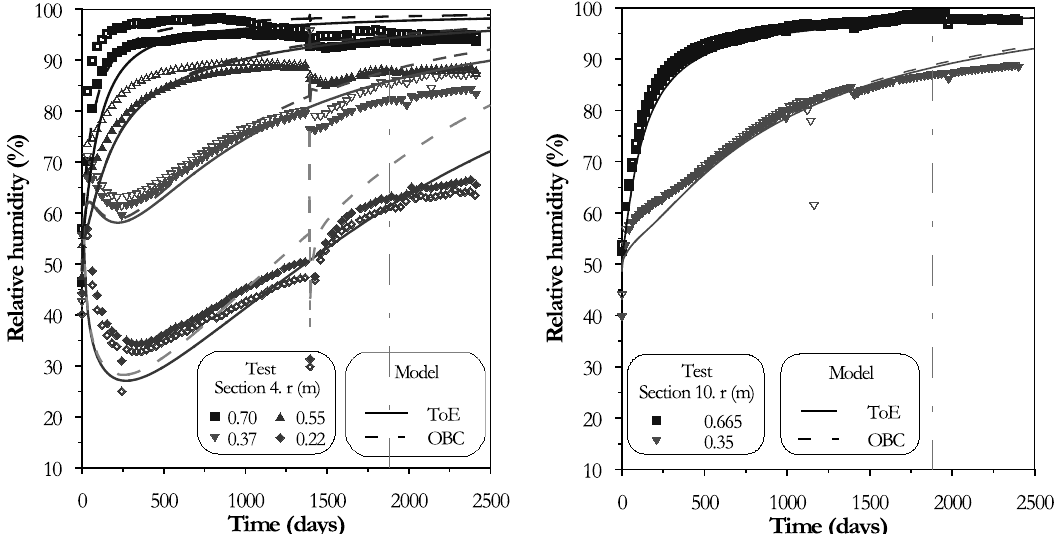
Fig. 12 – Evolution of the relative humidity. Observed versus computed values of ‘ToE’ (Thermo-osmotic Effect) and ‘OBC’ (Operational Base Case) models. a) Sections A4-B4. b) Sections